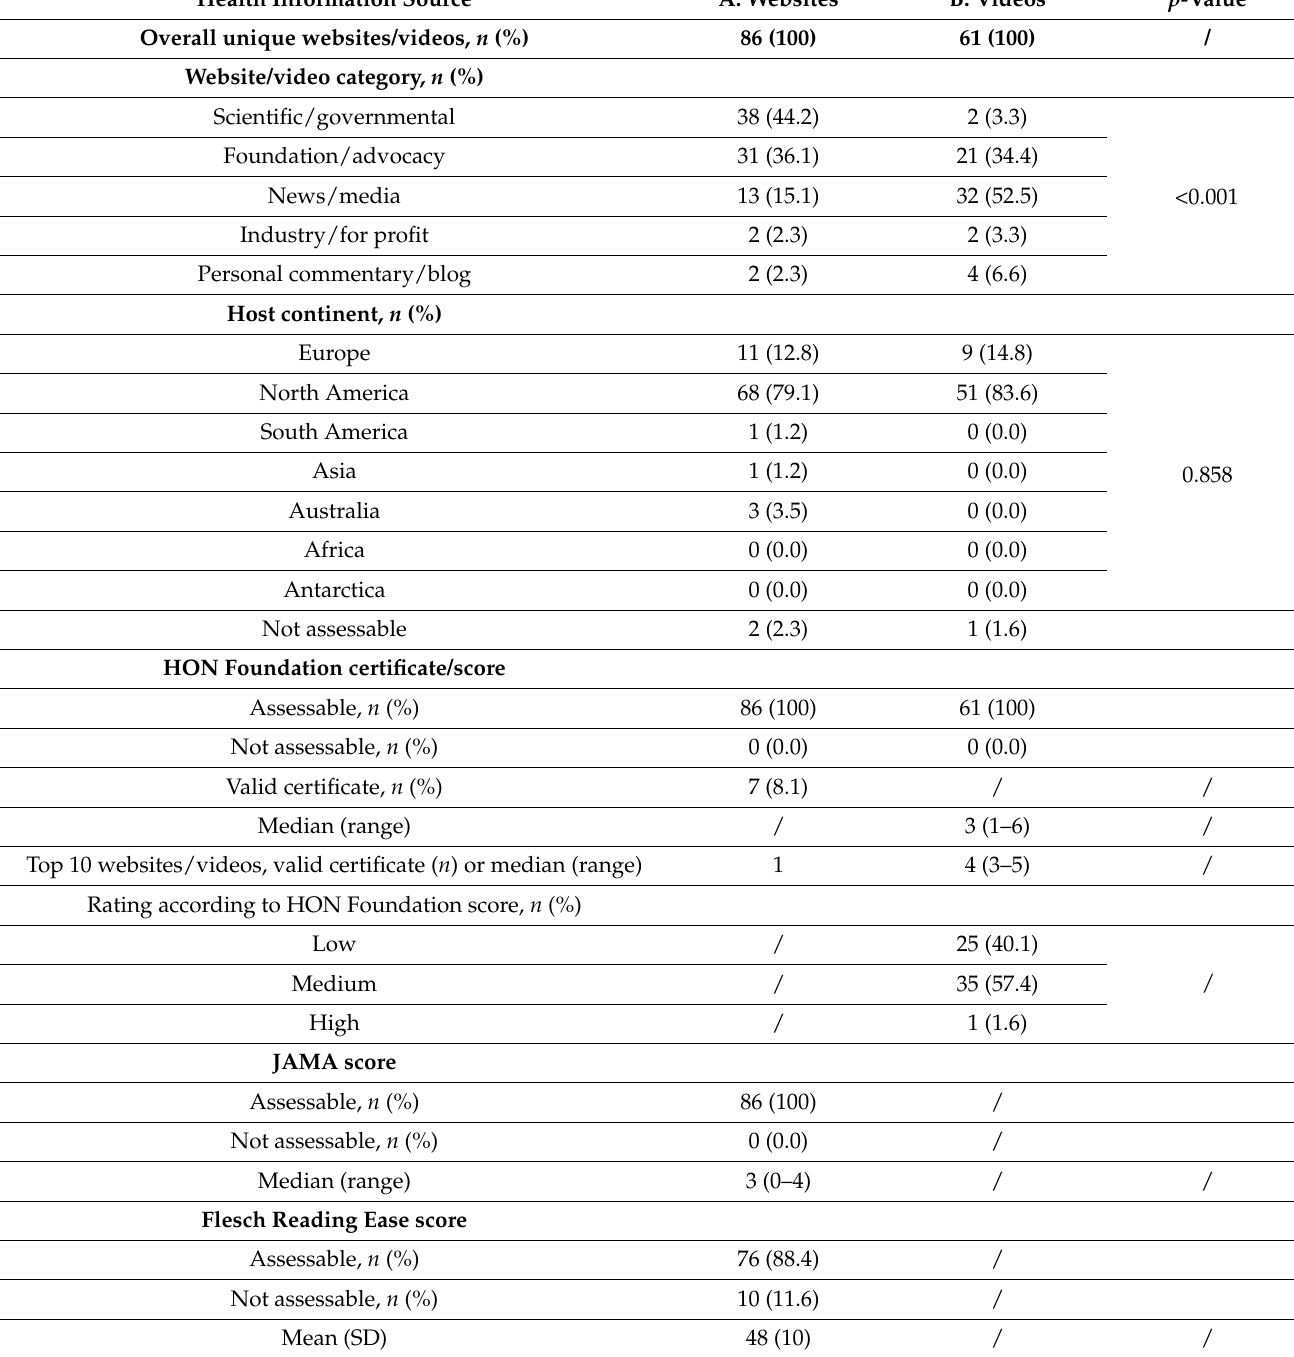
Table 2. Characterization of unique websites and